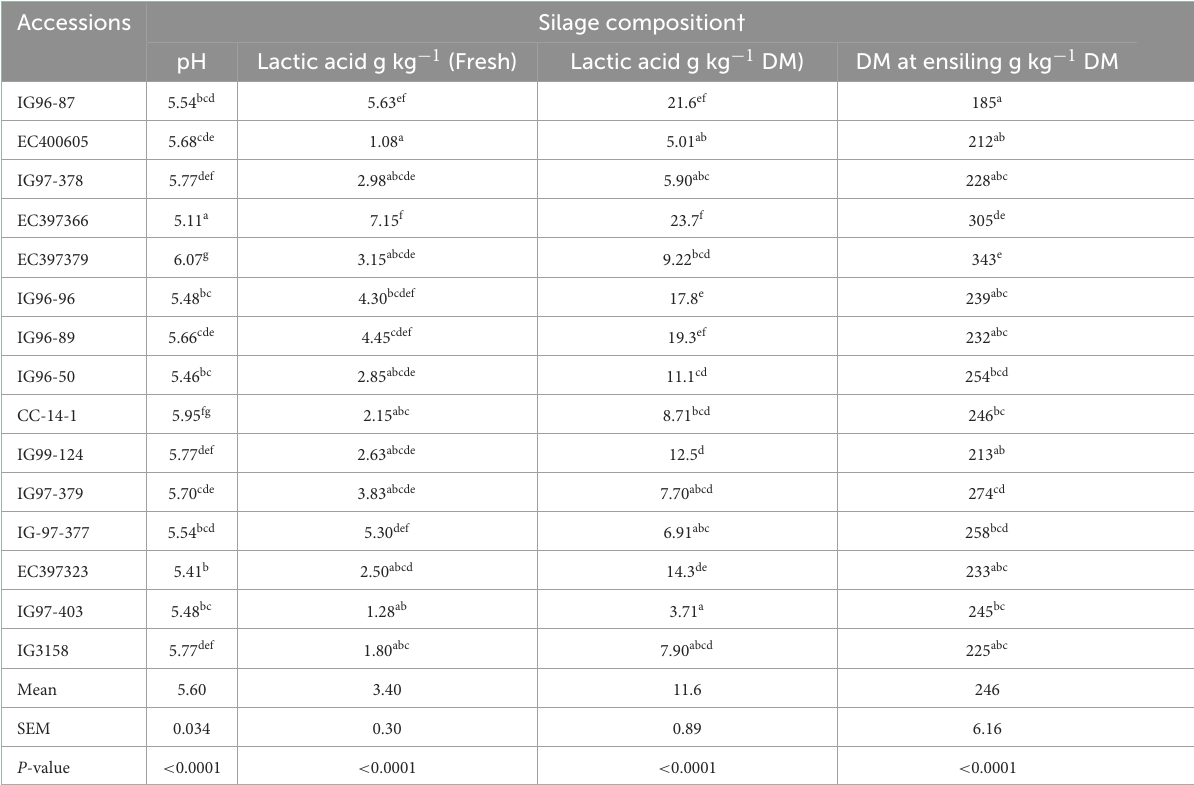
TABLE 8 Cenchrus ciliaris accessions silage